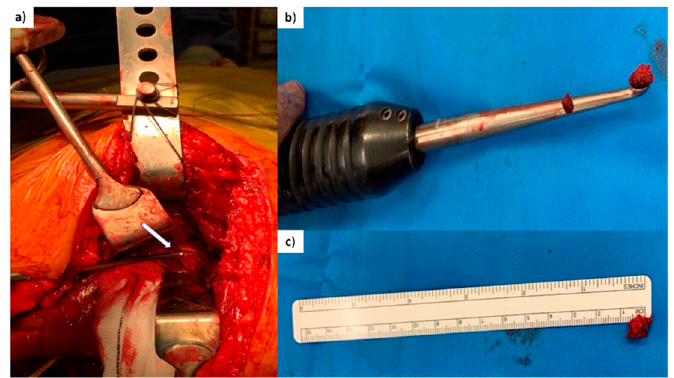
Figure 2. Surgical procedure .